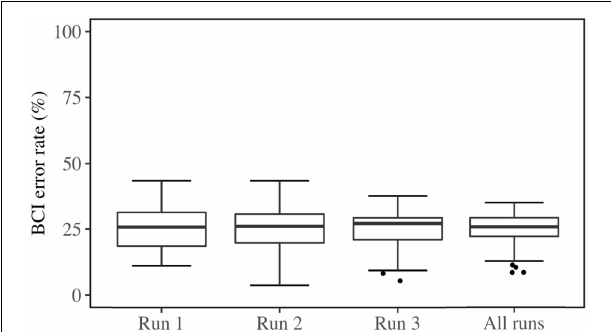
FIGURE 5 | Box plots of mean BCI error rates in every feedback run and all aggregated